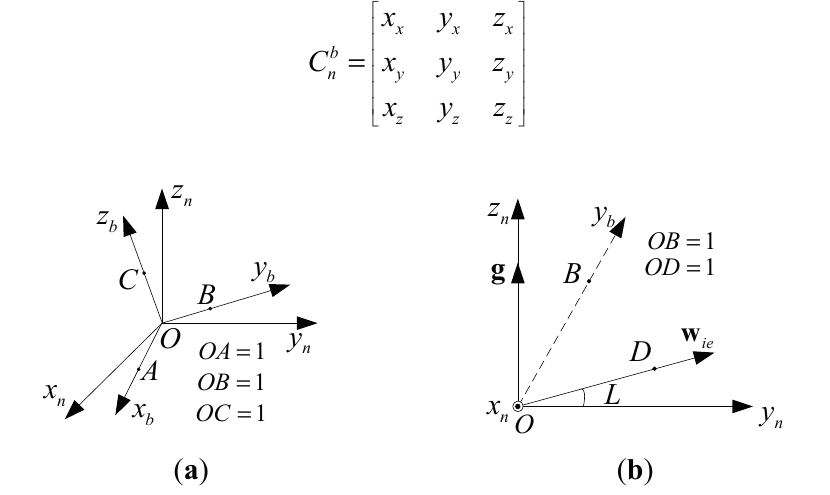
Figure 3. ( a ) The definitions of